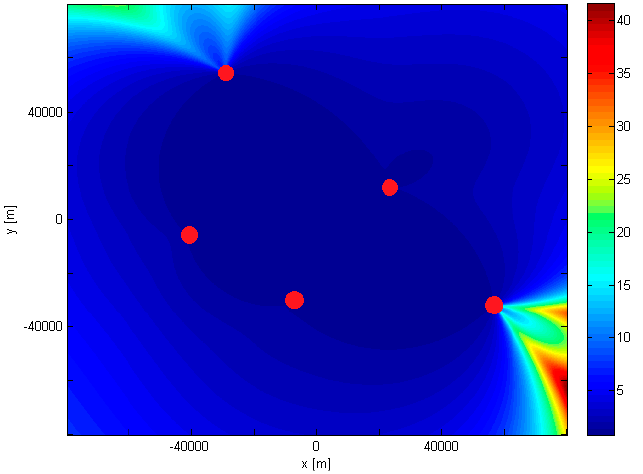
Figure 9. Accuracy fields (PDoP) of MLAT consisting of five stations.